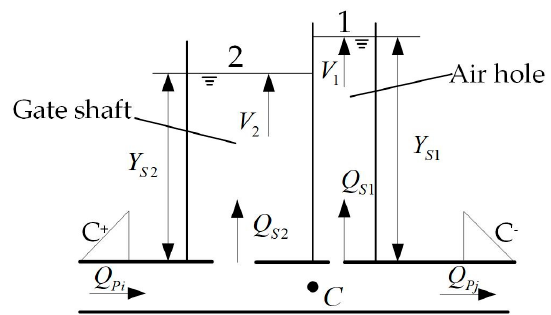
Figure 2. Schematic of gate shaft.